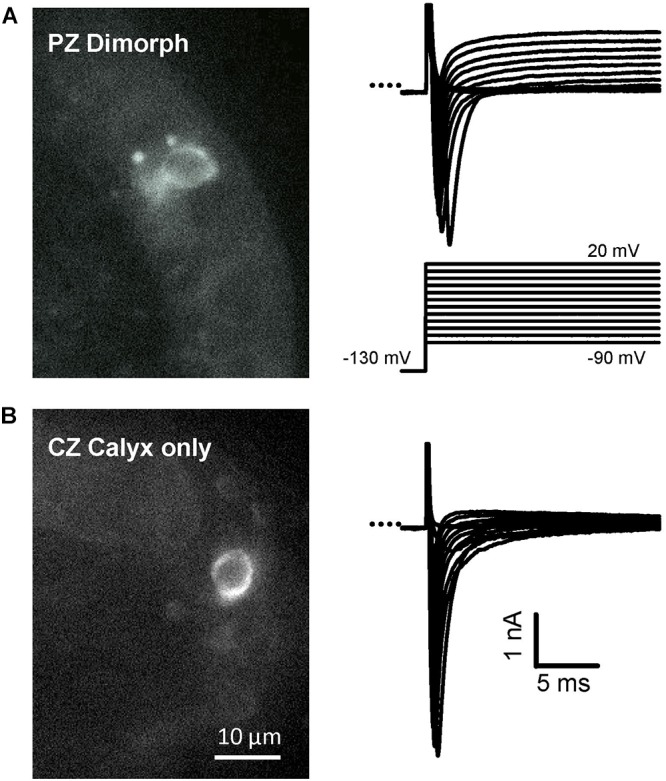
Examples of recordings from identified terminals in different zones. Alexa Fluor 488 was included in the electrode solution to label afferent endings in crista slices. (A) Dimorphic PZ afferent (left image, P27) with calyx and bouton terminal endings seen as a bright circle and two puncta with associated Na+ currents in response to the voltage protocol. (B) Calyx-only terminal in the central crista region (left image, P25). Corresponding Na+ currents recorded in voltage clamp are shown on the right. INa was isolated using internal Cs+ and 0 K+ HEPES solution. A small outward current persisted in the PZ cell but was minimal in the CZ cell. Scale bar shown in (B) apply to both (A,B).